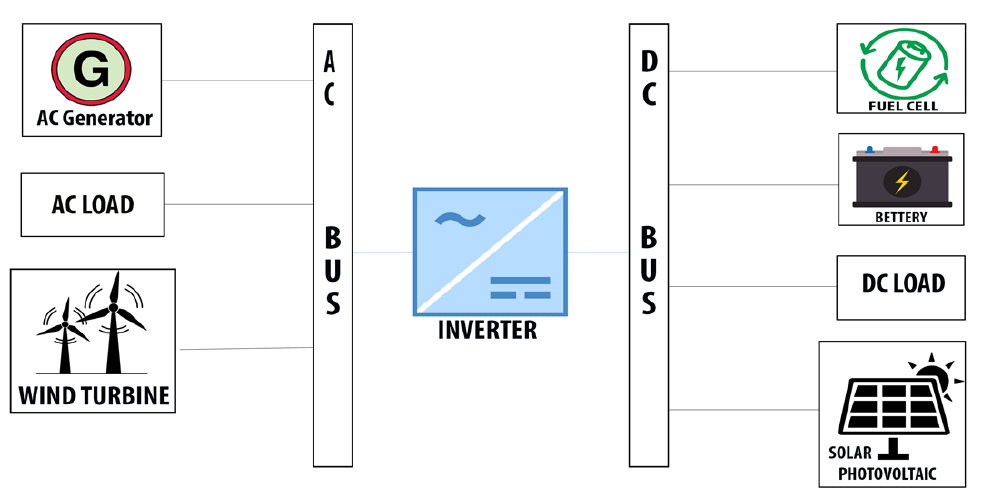
Figure 2. Hybrid